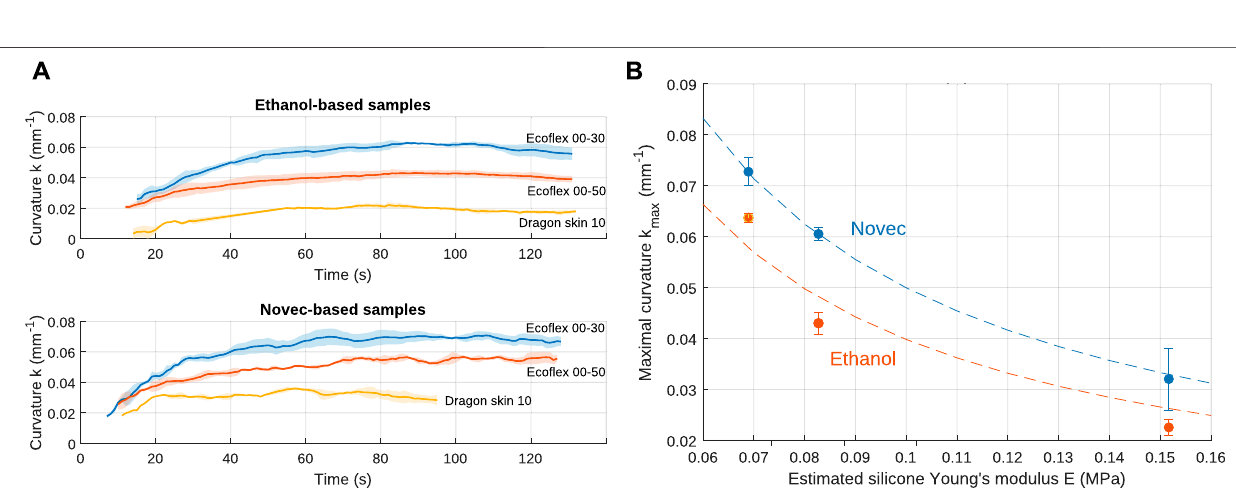
FIGURE 8 | In fl uence of the elastomer on the bending capabilities when heated at 10 ° C above the fl uid boiling points. (A) Raw results for ethanol and Novec for different silicones. The shaded areas represent the standard deviation. (B) Maximal curvature for each fl uid – material combination. The dashed lines are fi tted curves k ∼ ϵ (cid:1) 1 E